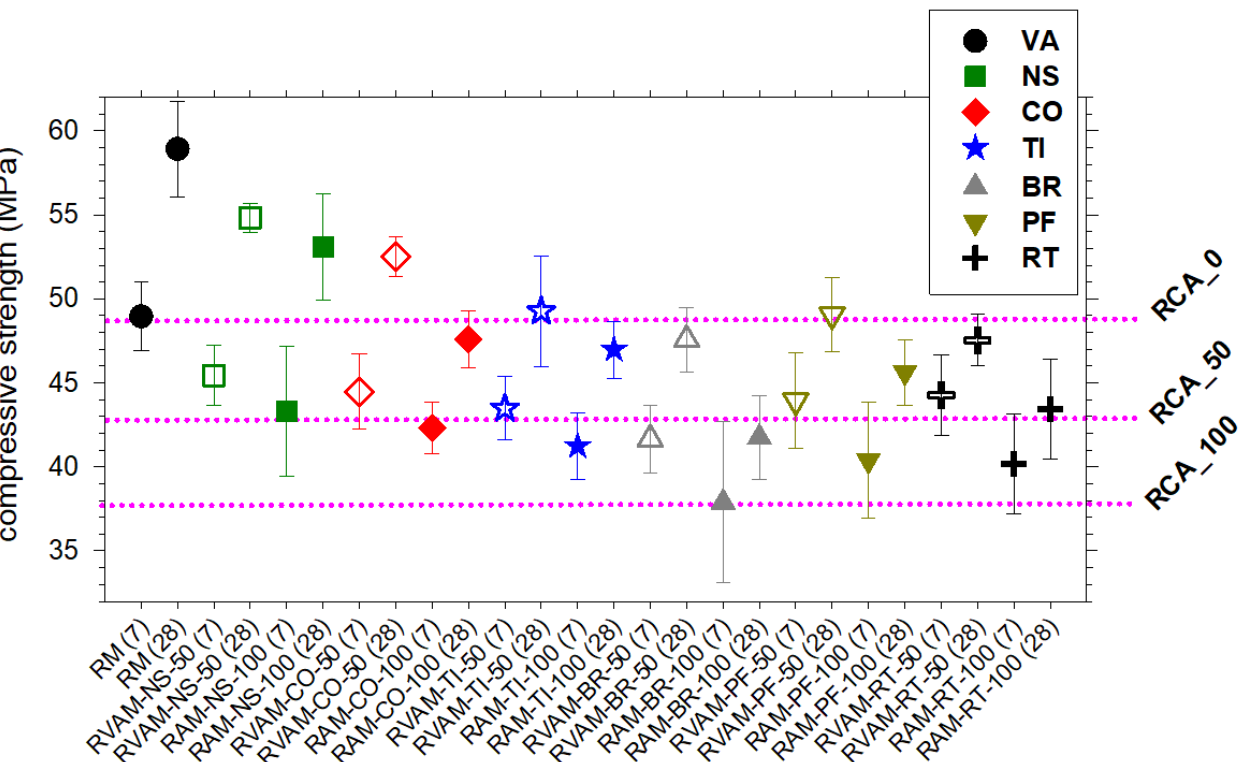
Figure 3. Variation of compressive strength for RM, RVAM and RMA. Unfilled symbols refer to RVAM and filled symbols refer to RAM. The horizontal pink lines correspond to the compressive strength of RACs prepared with normal strength RCAs and VA in the fraction of 0 and 100 wt.% (RCA_0), 50 and 50 wt.% of RCA and NA (RCA_50) and entirely with RCA (RCA_100), as reported in Figure 15.1 of [27] .